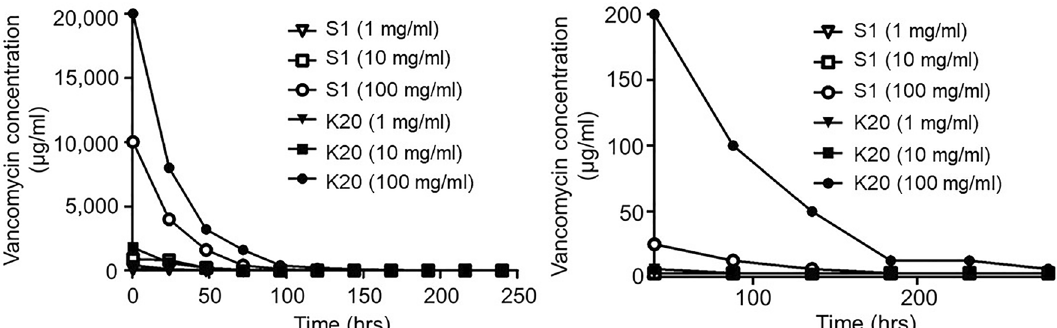
Figure 2. Uptake and elution of vancomycin as a function of scaffold formulation and antibiotic concentration. The S1 and K20 scaffold formulations were exposed to solutions of vancomycin at the indicated concentrations for 24 h. Scaffolds were removed and placed in PBS without vancomycin. The buffer was replaced with antibiotic-free buffer at the indicated time points and the approximate amount of active vancomycin determined using a broth microdilution assay. Left: Results from the entire 10-day elution period. Right: exploded view of data focusing on the later time of antibiotic in the eluate fell to a concentration comparable to that observed with the K20 scaffold saturated with 100 mg/mL antibiotic (~ 8.0 mg/mL). Thus, as defined by the overall elution profile, we considered the K20